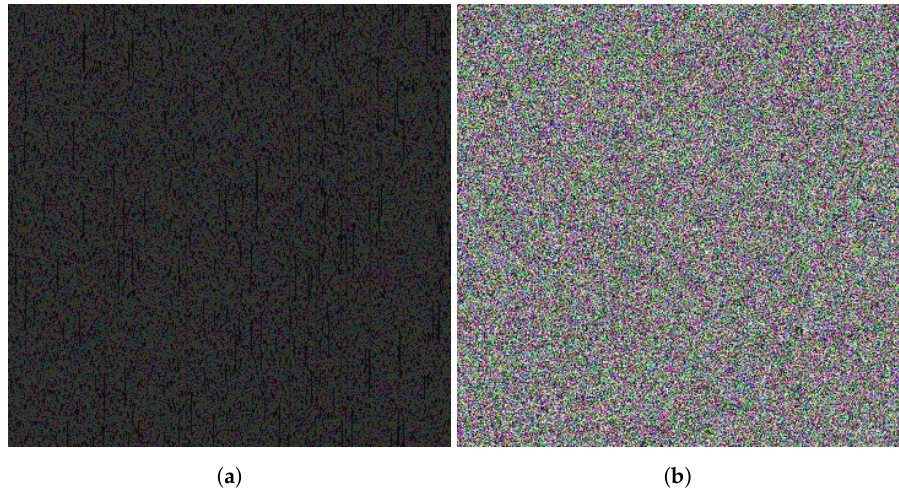
Figure 5. Test File 2 text message as image png and its cipher-image. ( a ) Text message in image form. ( b ) Encrypted image.